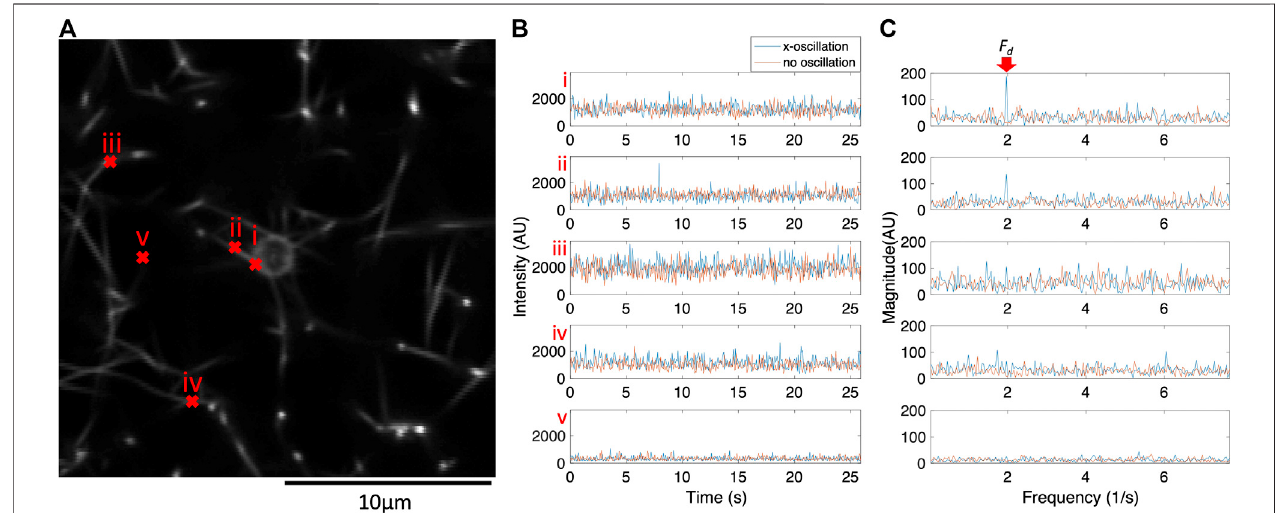
FIGURE1| Thefrequencycomponentsofpixelintensity fl uctuationsforasubsetofpixelsrespondtothephysicaloscillationsofthebead. Forthissubsetofpixels, peak intensity fl uctuations occur at the same frequency as the optical tweezers oscillation ( F d ). (A) Time averaged fl uorescence intensity image. White regions are fi bers labeled with fl uorescent dye. The bead is in the center of the image. Red X symbols indicate the position of representative pixels shown in panels (B,C) . Point i is on the edge of the bead. Point ii , iii , iv are on fi bers. Point v is in the liquid region. (B) Fluorescence intensity of pixels over time with optical tweezers either oscillating in the x -direction (blue) or not oscillating (orange). (C) Magnitude spectra of the 1-D Fourier transformed fl uorescence intensity in time with optical tweezers either oscillating in the x -direction (blue) or not oscillating (orange). A red arrow highlights F d .